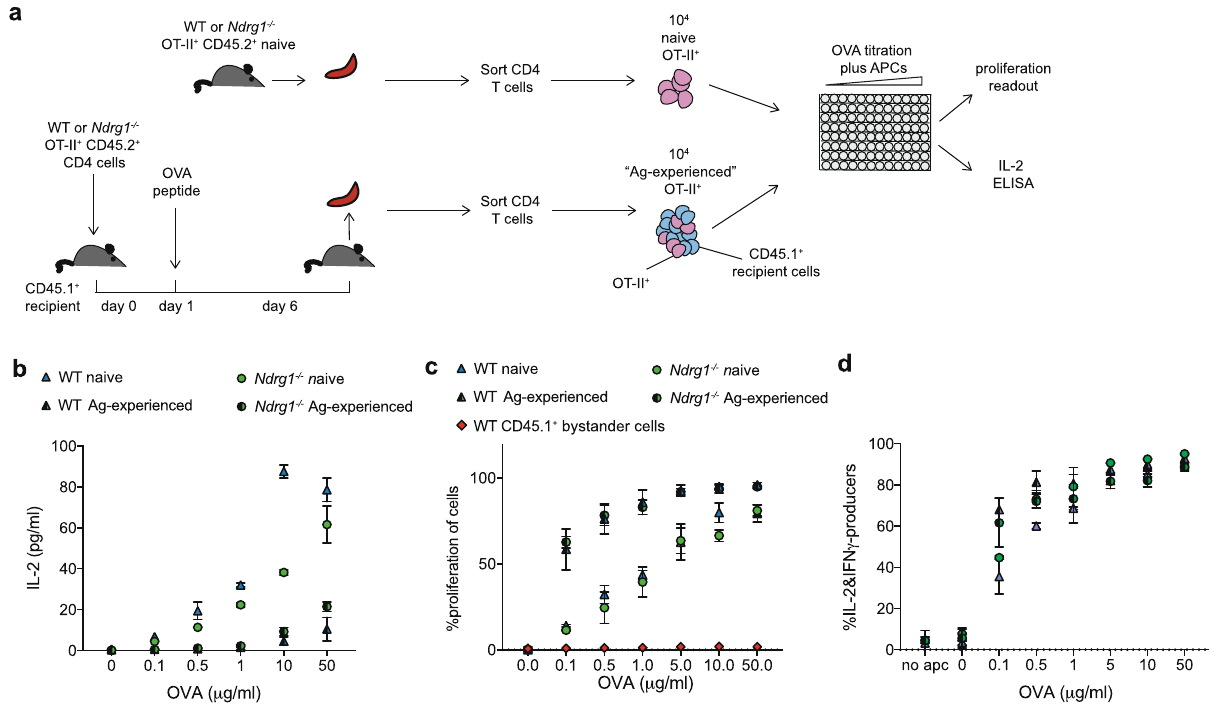
Fig. 7 Antigen-experienced T cells respond normally in the absence of NDRG1. a Experimental schematic; OVA-speci fi c CD4 + OT-II + T cells were isolated from CD45.2 + WT or Ndrg1 − / − OT-II + tg mice and adoptively transferred to CD45.1 + non-tg recipients, with subsequent intravenous injection of 500 μ g OVA peptide. After 5 days, splenic CD4 + cells were isolated from recipient mice and naïve unstimulated WT or Ndrg1 − / − OT-II + tg mice and loaded with CTV. Equal numbers of V α 2 + CD45.2 + OT-II + cells were cultured in vitro with a titration of OVA peptide for 72 h at 37 °C with irradiated APCs. b IL-2 concentration in culture supernatants in ( a ). c Proliferation of CD4 + V α 2 + CD45.2 + OT-II + T cells and non-tg bystander WT CD45.1 + cells (red) as measured by CTV dilution by fl ow cytometry. d Quantitation of intracellular IL-2 and IFN γ production by fl ow cytometry within OT-II + CD4 + T cells from ( a ). Points represent means of technical replicates from one (naïve) or two (antigen-experienced) mice with error bars representing standard deviation. Results are representative of two ( b ), three ( c ) or one ( d ) independent